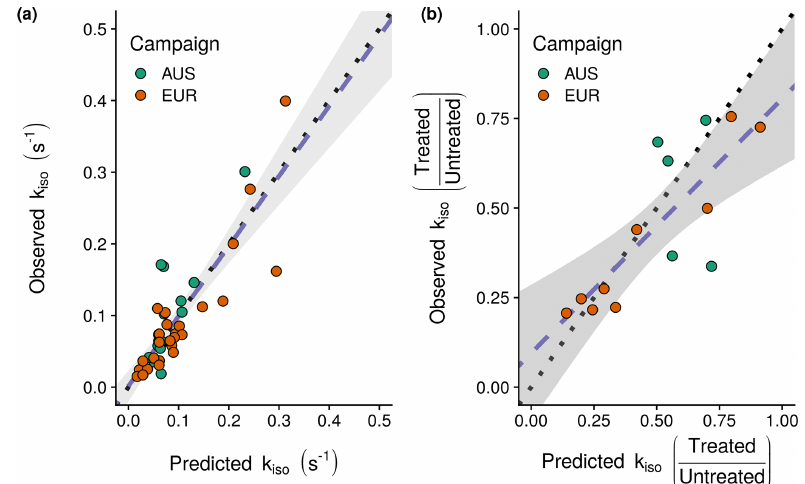
Figure 4. Rates of oxygen isotope exchange ( k iso ) predicted by the minimal adequate statistical model identified (Eq. 6): (a) model pre- dictions for the 44 untreated soils against the observations for these soils used in model fitting and (b) predicted fractional changes in kiso between treated and untreated soils against the changes observed following NH 4 NO 3 addition. Plotted points indicate individual sites with the associate sampling campaign indicated by colour (EUR: orange, AUS: green), dotted lines indicate the 1 : 1 line and dashed blue lines indicate linear relationships between predicted and observed values with a shaded 95% confidence interval.